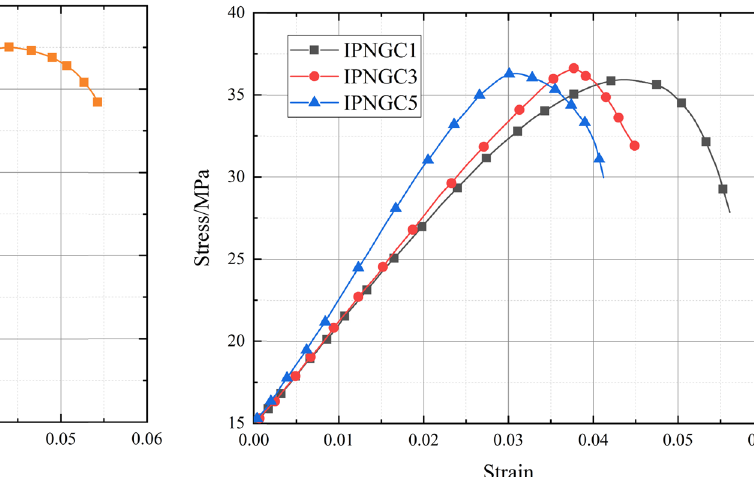
Figure 9: IPNG stress – strain